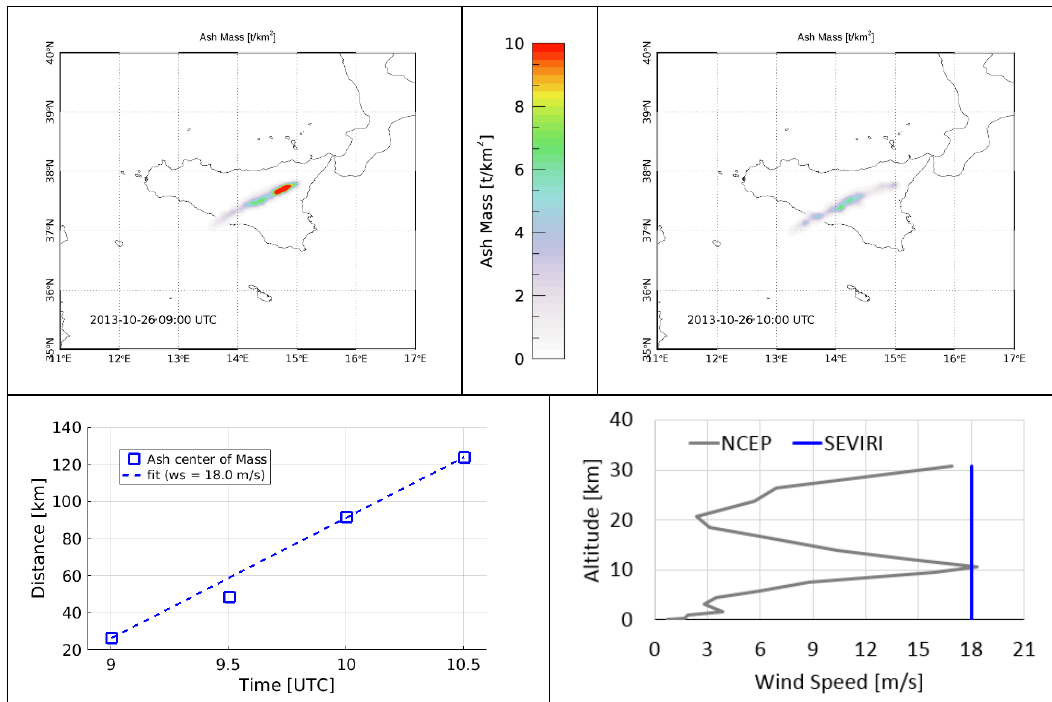
Figure 6. Upper panels: volcanic cloud ash mass maps obtained from the spinning enhanced visible and infrared imager (SEVIRI) images collected at 09:00 UTC ( left panel ) and at 10:00 UTC ( right panel ). Lower panels: Computation of the volcanic cloud speed from SEVIRI images ( left panel ) and comparison between the value obtained and the wind speed NCEP/ National Center for Atmospheric Research (NCAR) profile ( right panel ).